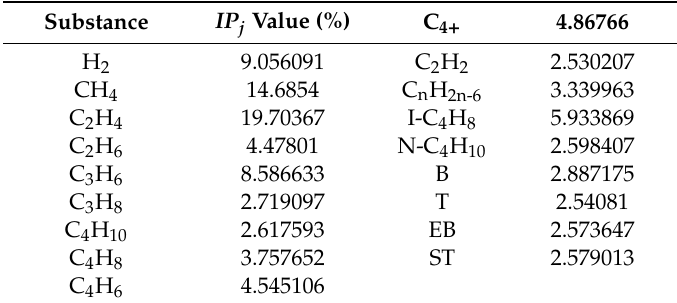
→ IP tr value of each substances in naphtha Table 8. The